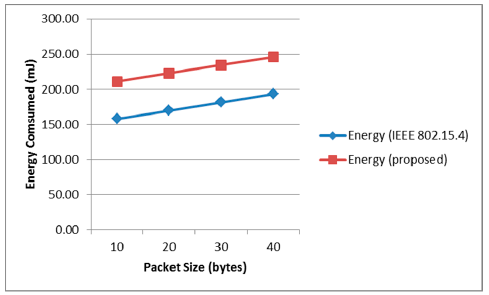
Figure 6. Maximum Energy Consumption of the proposed scheme and the conventional IEEE 802.15.4.